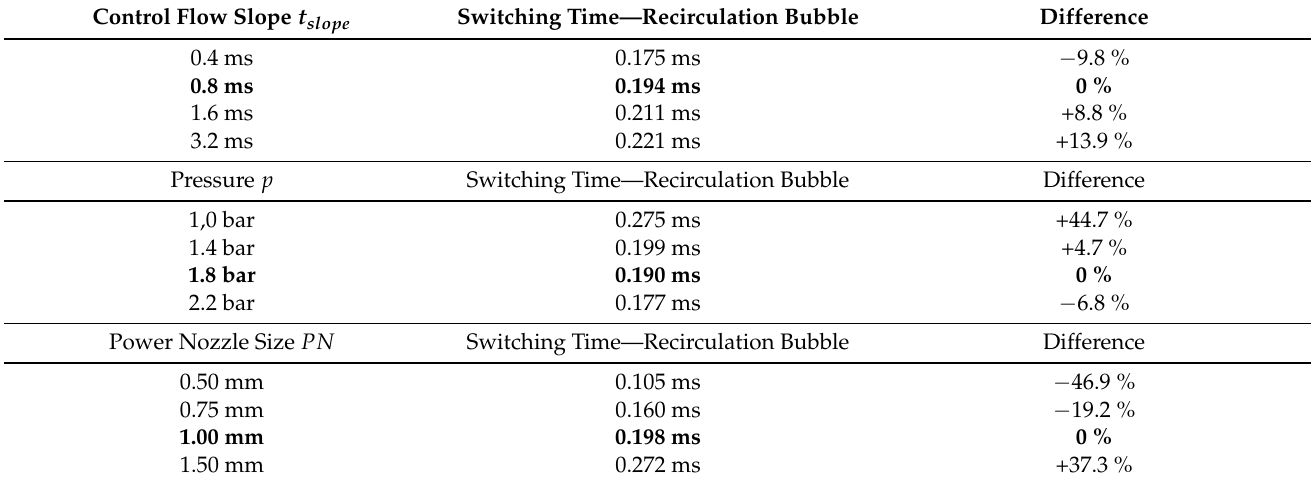
Table 2. Results of the parametric simulations. Baseline values are printed in bold letters. Control Flow Slope t